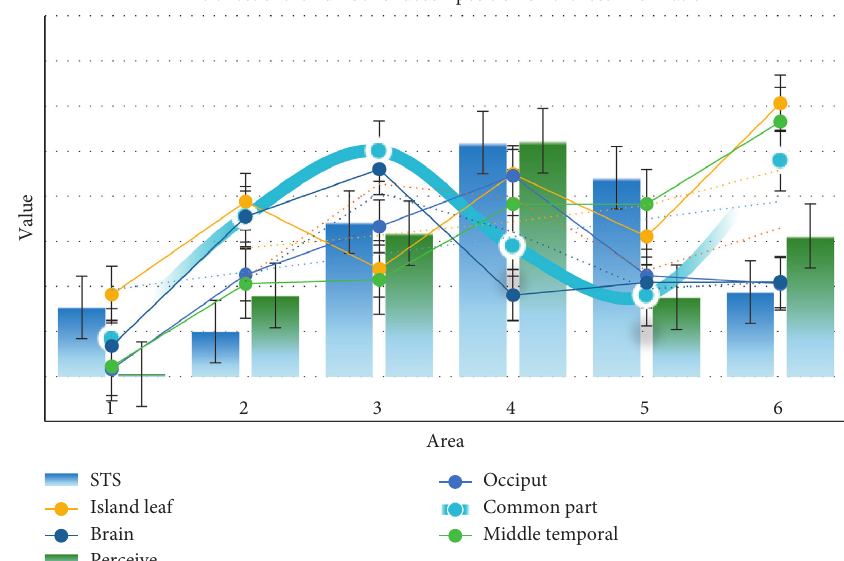
Figure 11: The effect of the number of decomposition layers on the lost information.